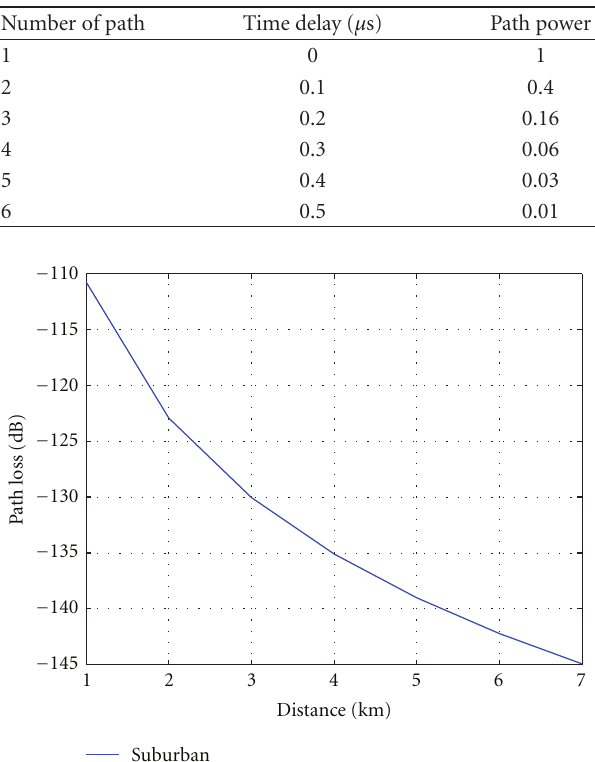
Table 1: Parameters of the suburban model in COST 207.